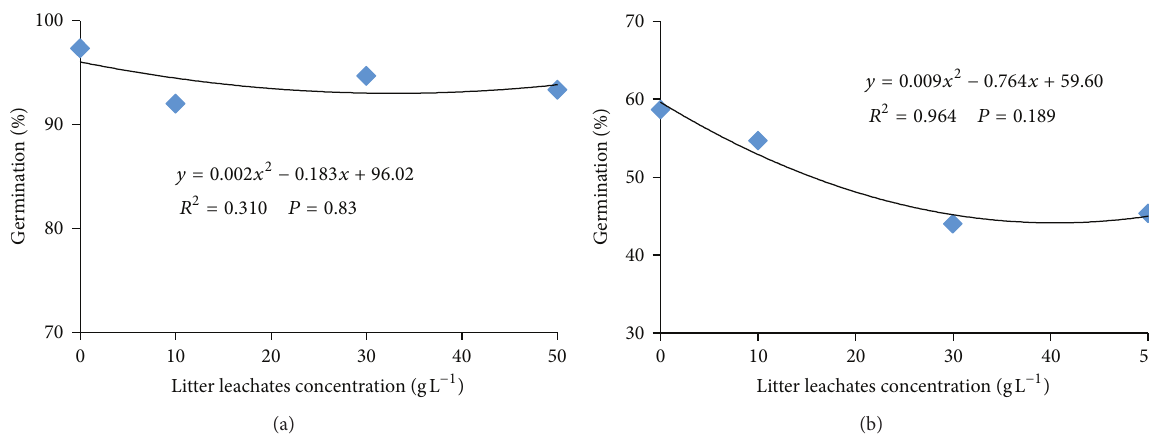
Figure 1: Dose-response relationship curve of the effect of A. compressus litter leachates on final germination percent of A. gangetica (a) and P. polystachion (b).